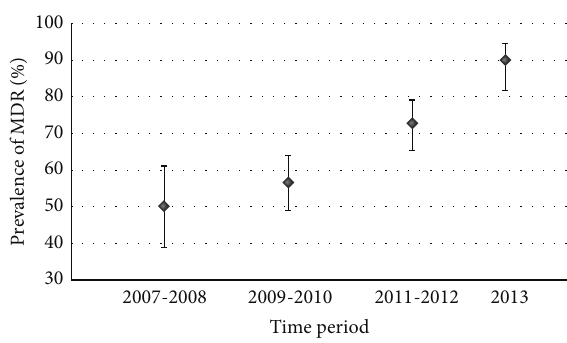
Figure 4: Change of the prevalence of multidrug resistance among E. coli isolated from diseased dogs and cats in Poland between January 2007 and December 2013.